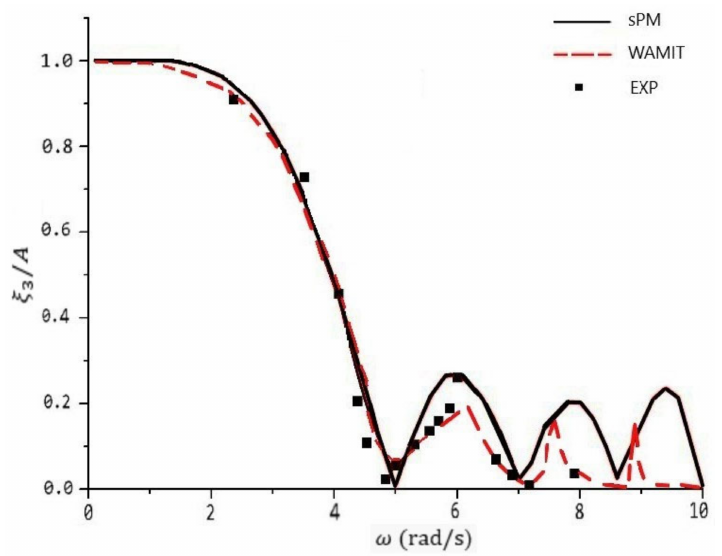
Figure 5. Heave RAO obtained by the sPM as compared with WAMIT results [23] and experimental data